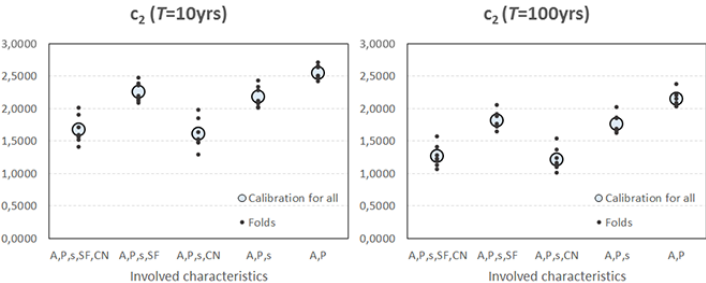
Figure 22. Values of parameter c 2 calibrated to the whole data set and to 7 folds for N = 10 years (left panel) and N = 100 years (right panel).